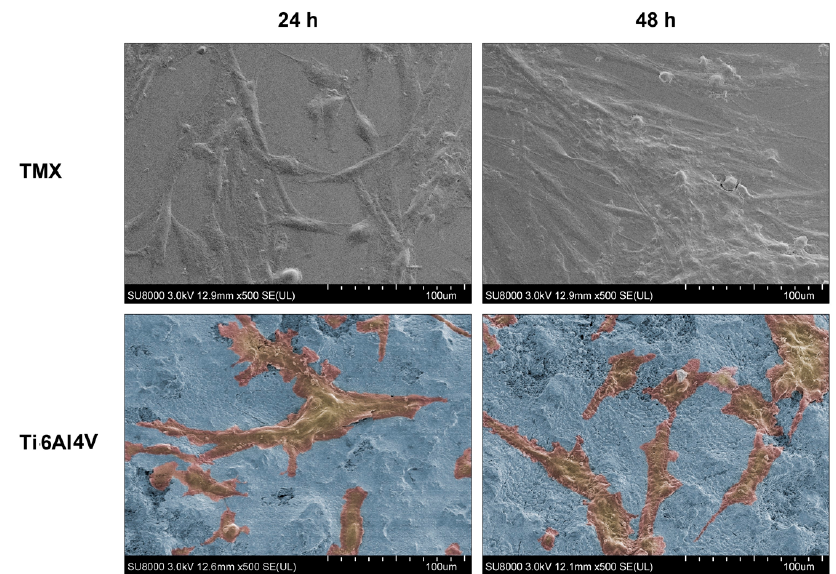
Figure 13. SEM images (×500) of cultures of human osteoblasts seeded on the surface of the TMX control and studied system, after placing samples in culture for 24 and 48 h. A false colour reconstruction has been used to show the proliferation of the human osteoblasts